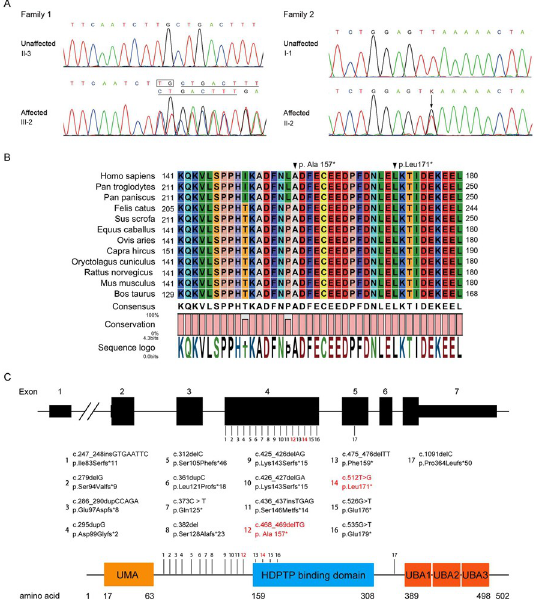
Fig 2. Confirmation of novel variants of UBAP1 . (A) Sequence chromatogram showing the c.468_469delTG (family 1) and c.512T > G (family 2) variants in UBAP1 in the probands. The variants were numbered according to GenBank NM_016525.4. (B) Sequence alignment of mammalian UBAP1 protein showed that the regions around the variants were highly conserved. The numbers on the left and right indicate where the fragment was located within the entire protein sequence. The positions of the variants are marked by black triangles. (C) Mutations identified in SPG80. The numbers indicate the locations of mutations in DNA and protein. The mutations found in this study are marked in